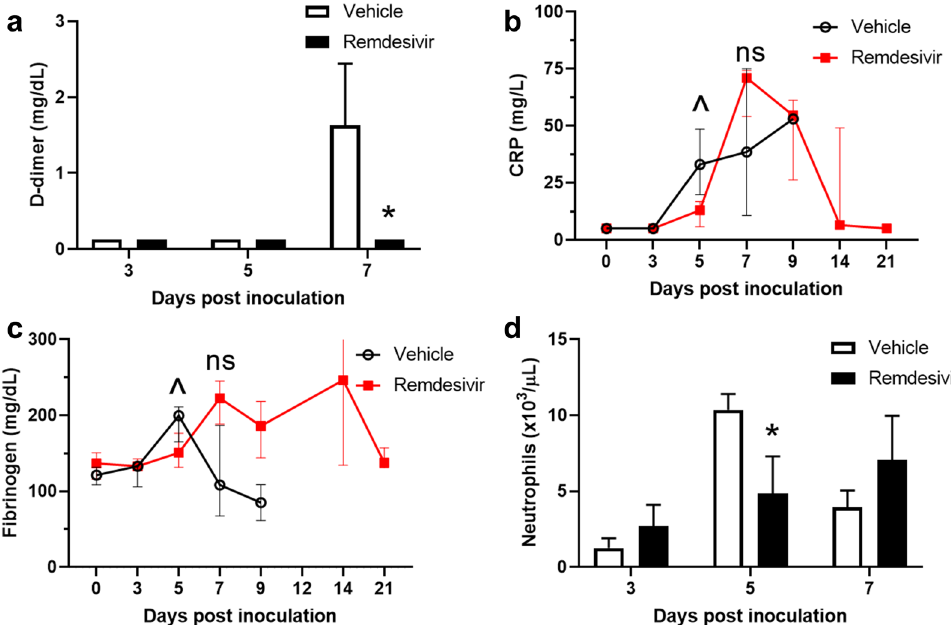
Figure 2. Systemic inflammatory responses. ( a ) D-dimer on day 7 PI is significantly reduced in remdesivir treatment group (filled bar) versus vehicle control group (open bar); p = 0.03 (Wilcoxon rank-sum test). Concentrations of ( b ) C-reactive protein (CRP) and ( c ) fibrinogen demonstrate trends (^p < 0.1) toward significant differences between remdesivir (red filled squares) and vehicle (black open circles) groups at day 5 PI. ( d ) Neutrophil counts are significantly different by day 5 PI, p = 0.05 (Wilcoxon rank-sum test). Values represent the group medians and interquartile ranges with statistically significant differences noted (*p < 0.05); ns not